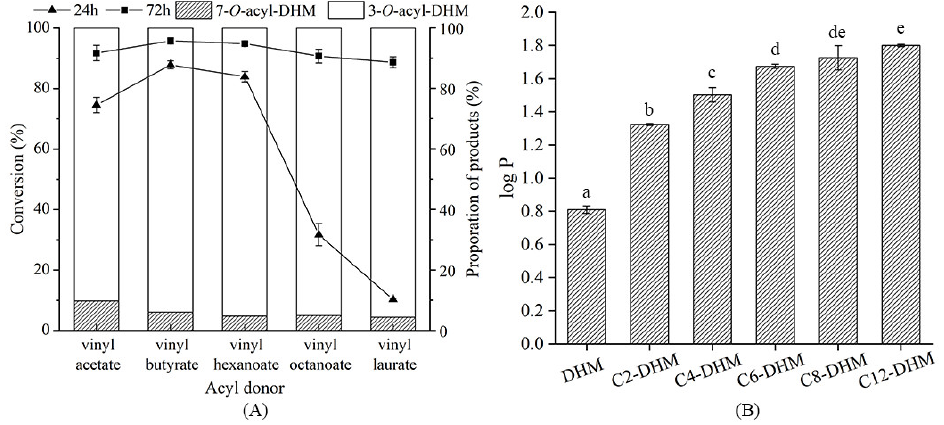
Figure 6. ( A ) Effect of the acyl donor. Reaction conditions: DHM = 0.18 mmol, 50 °C, 200 rpm, MTBE = 10 mL, acyl donor = 3.6 mmol (molar ratio of DHM to acyl donor = 1:20), Lipozyme TL IM = 0.4 U/mg DHM. ( B ) The log p value of DHM and its acylated derivatives (different let- ters indicate significant difference in the same column ( p <